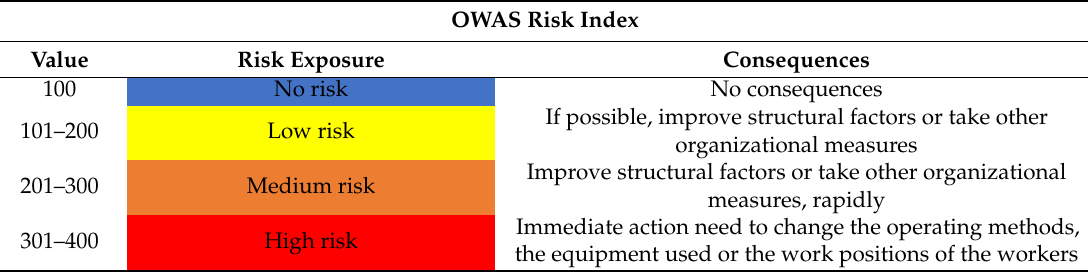
Table 6. OWAS index—risk areas.